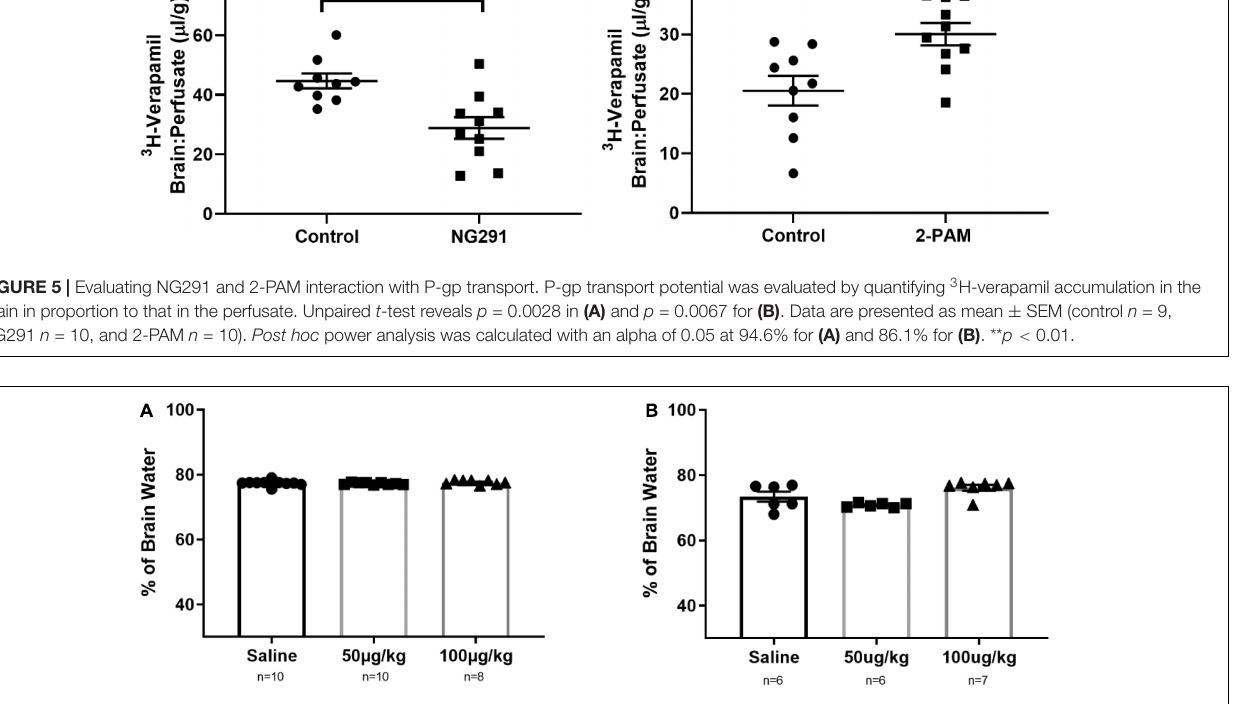
FIGURE 6 | NG291 influence on the brain water content in male and female Sprague Dawley rats. Brains were harvested and weighed after being left overnight following the administration of the experimental condition. Then, they were dehydrated until the weight no longer fluctuated. Panel (A) represents data for male rats, while female rats are represented in (B) . Data are presented as mean ± SEM. One-way ANOVA with post hoc Tukey’s test for multiple comparisons was employed (mean ± SEM; p > 0.05 in all